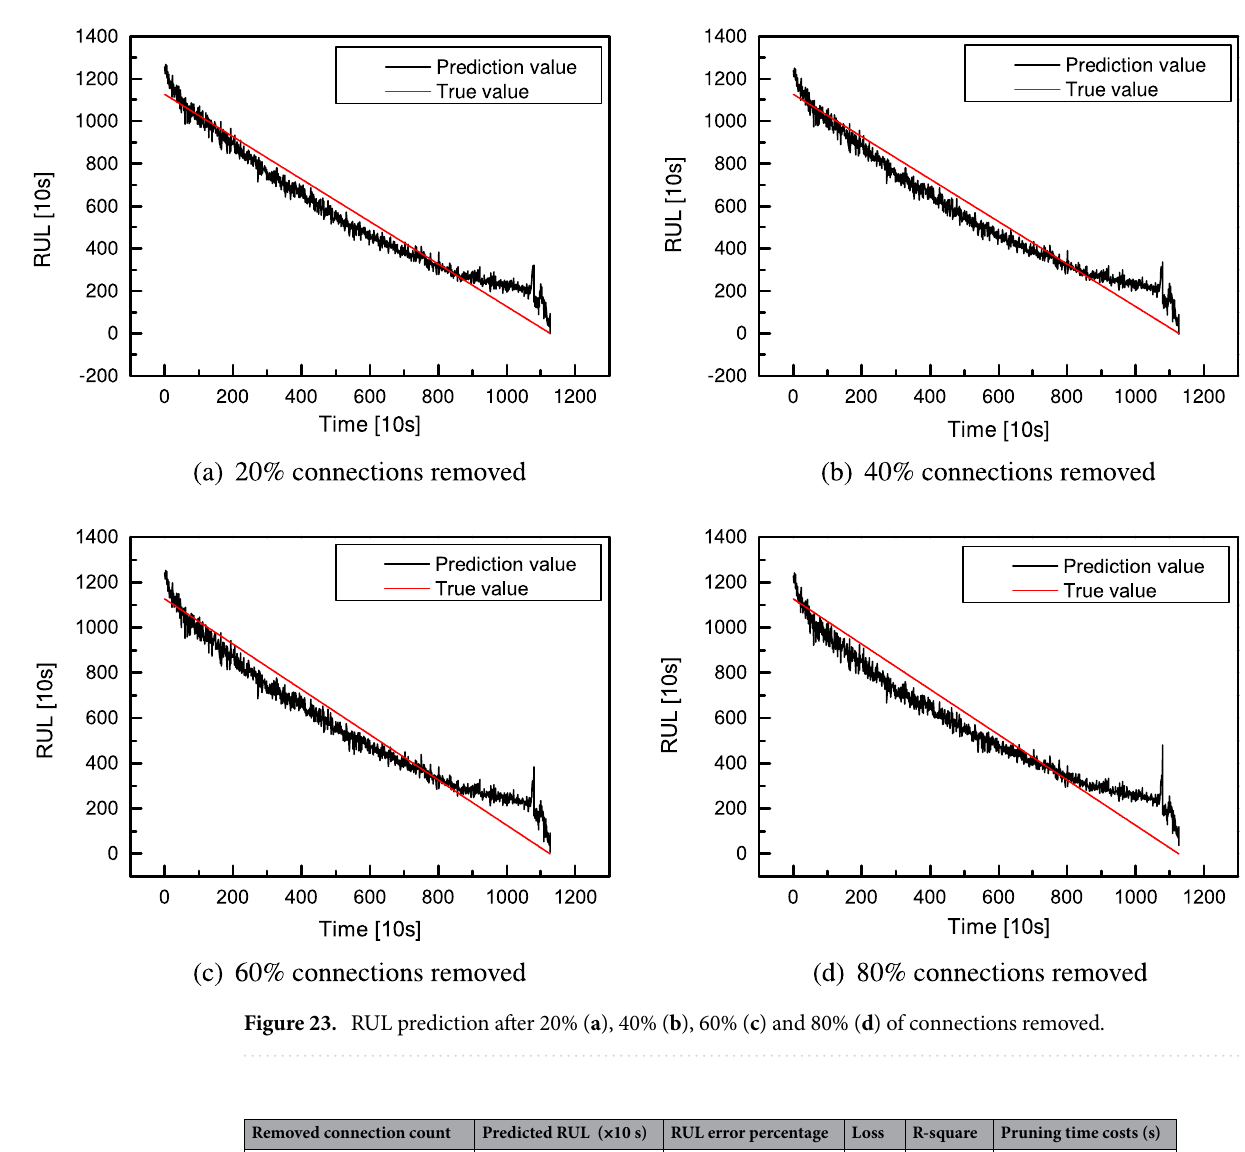
Figure 23. RUL prediction after 20% ( a ), 40% ( b ), 60% ( c ) and 80% ( d ) of connections removed.